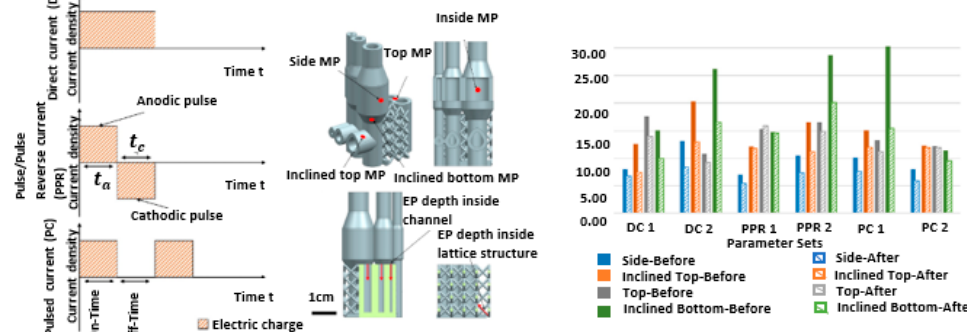
Figure 22. The electropolishing of complex steel SLM parts with various waveforms, geometric details and average mean height Sa [57] (open access article distributed under the terms and conditions of the Creative Commons Attribution (CC BY) license).